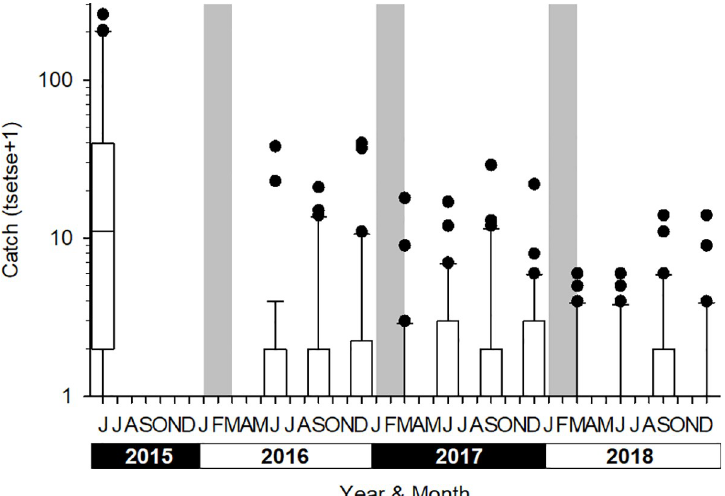
Fig 5. Boxplot of the catch of tsetse from 30 monitoring traps, each operated for 48 h, before and after Tiny Targets were deployed (grey vertical bars) in Bonon. The boxplot shows the median and interquartile range, whiskers show the 10th and 90th centiles and the black circles show all values > 90th centile.